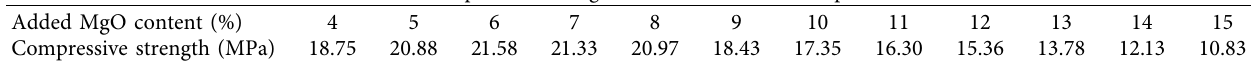
Table 4: Compressive strength of autoclaved mortar